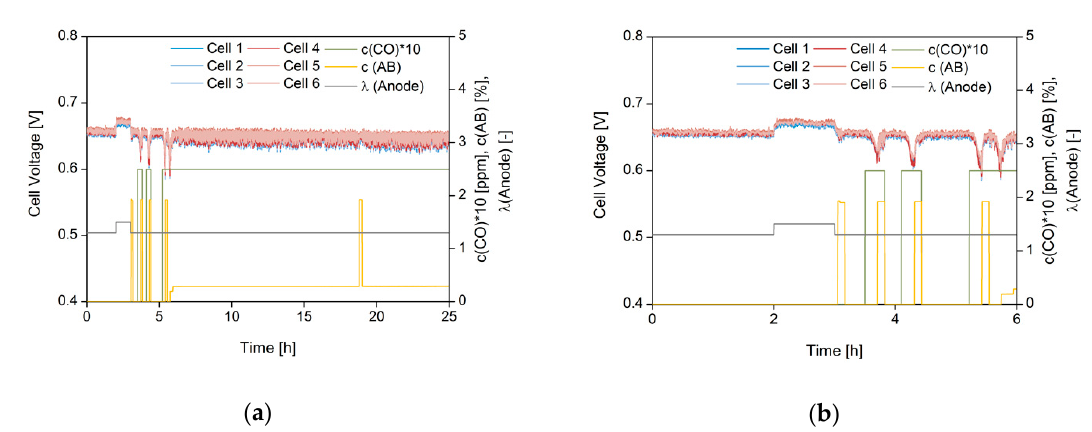
Figure 3. Results of algorithm startup test at standard operation and 80 A using Stack 01. ( a ) Full test sequence with 20 h of constant operation with 25 ppm CO and ( b ) detection phase in detail.